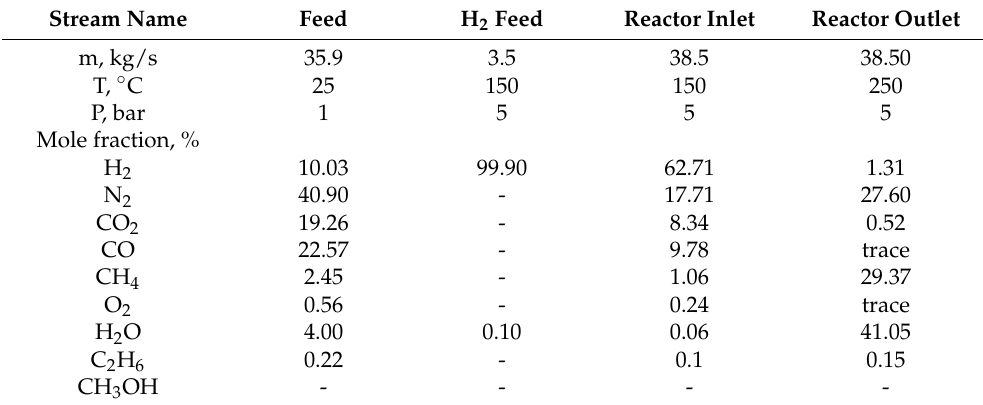
Table A4. Stream results of the combined case—methanation.